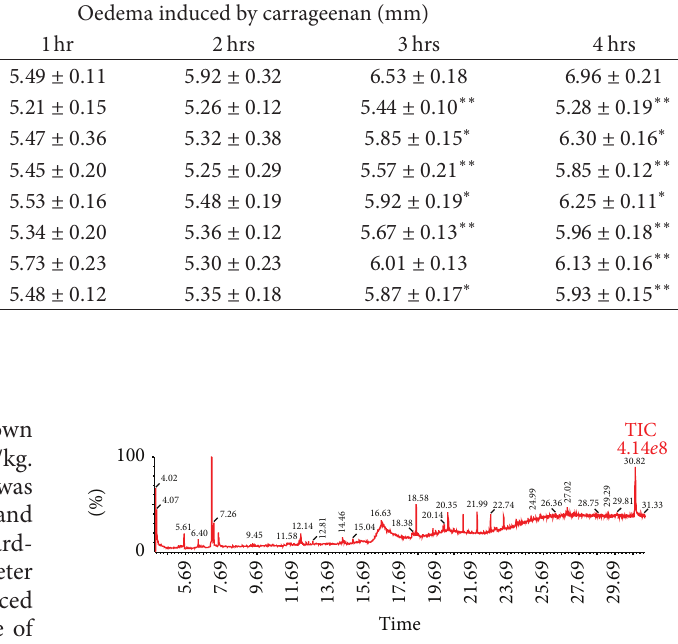
Figure 1: GC-MS chromatogram of ethanol extract of C. australe